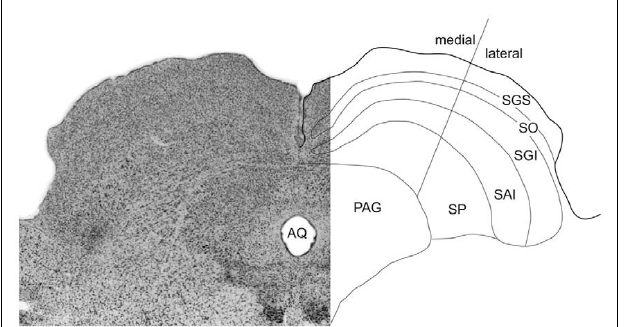
FIGURE 2 | Sub-regions of the SC. On the left a photomicrograph of the SC’s cytoarchitecture (Nissl stained). Layers are identified in a reflected schematic (right).The medial/lateral sub-regions approximates the horizontal meridian in the collicular map of visual